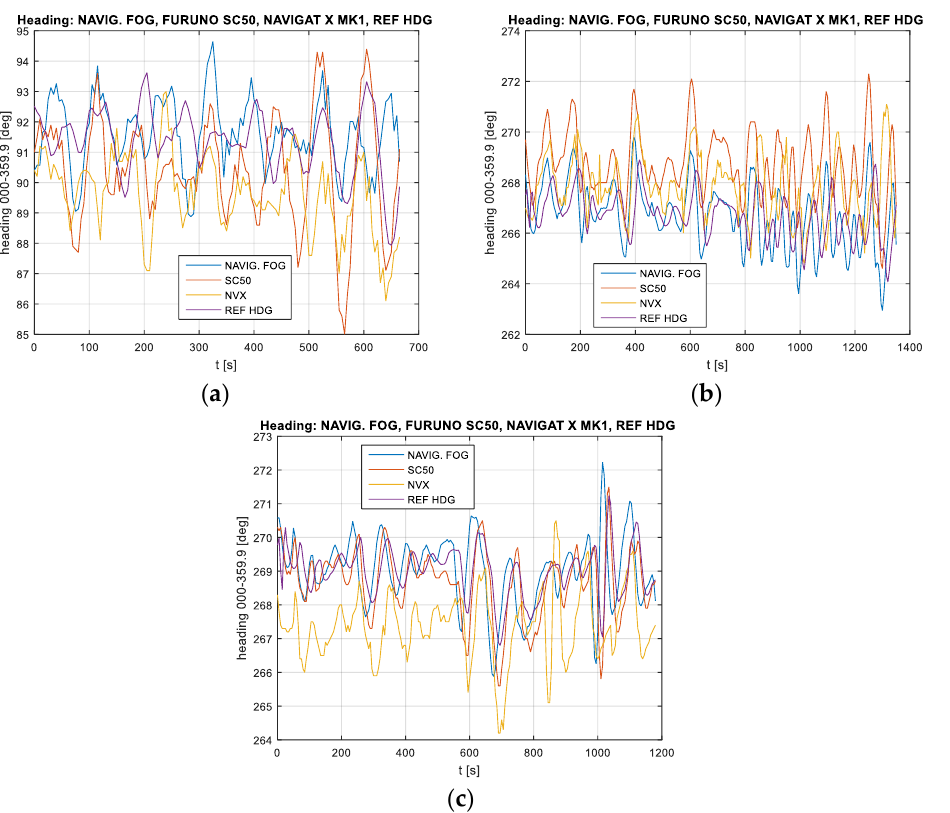
Figure 4. Selected recordings made on the ORP Arctowski ship: ( a ) test #1, ( b ) test #2, and ( c ) test #3.